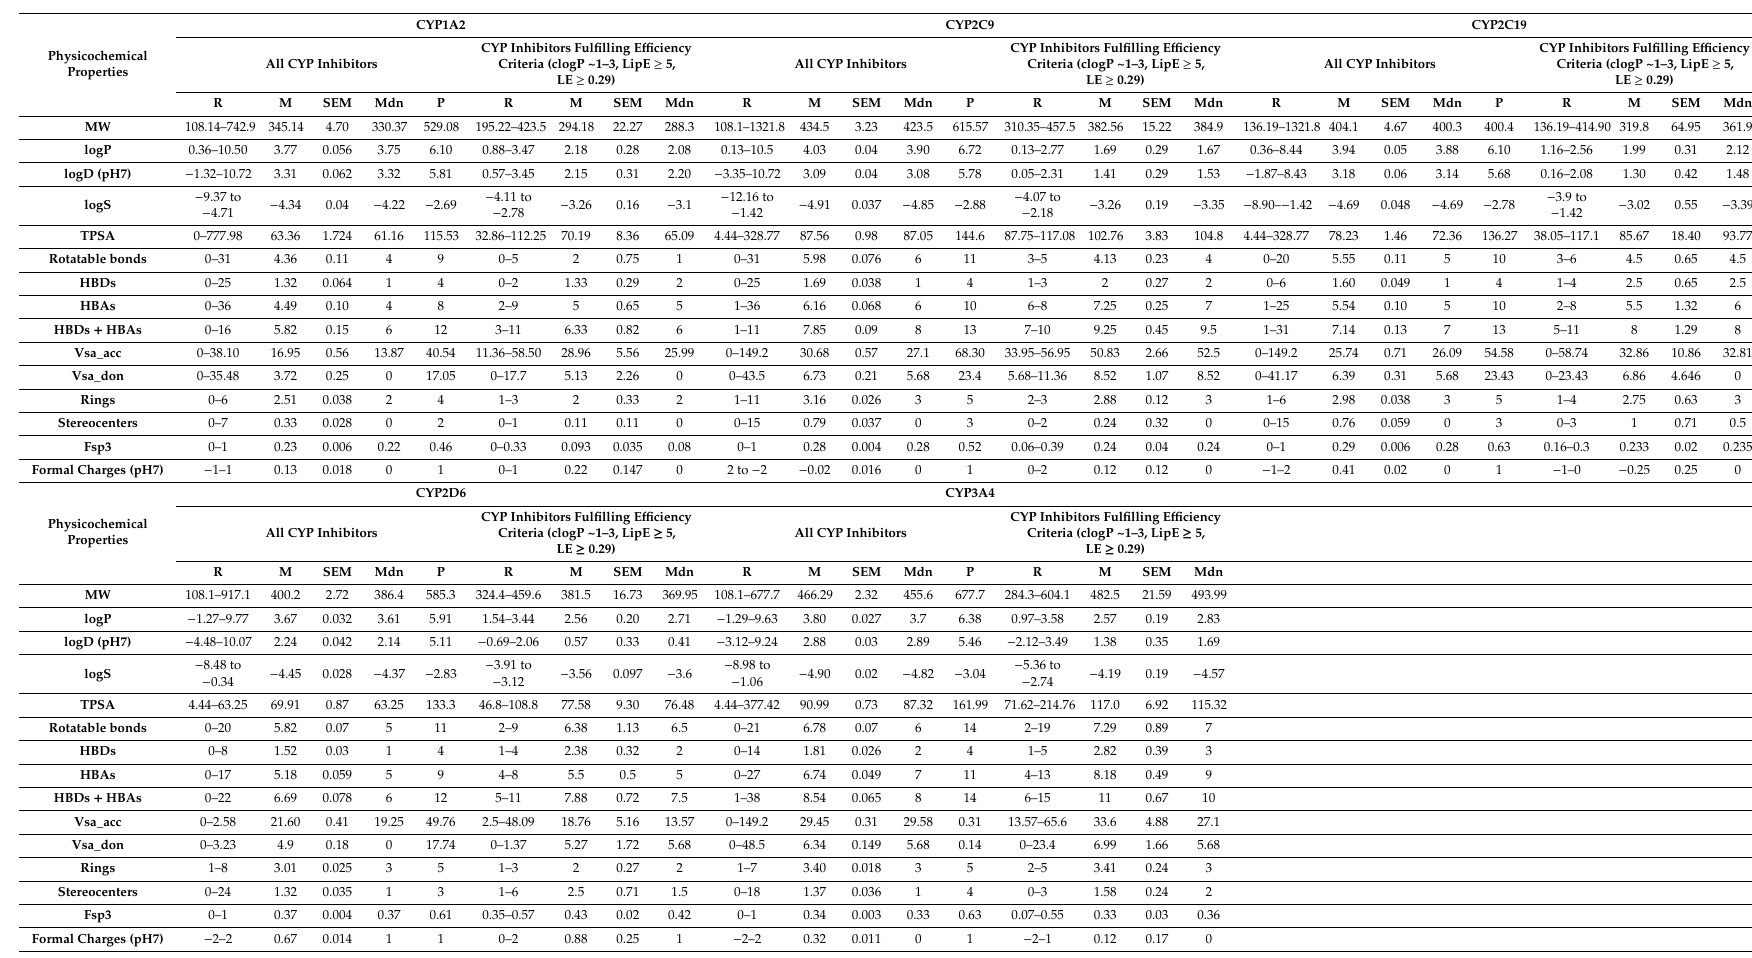
Table 2. The range (R), mean (M), standard error of mean (SEM), median (Mdn) and 95% percentile (P) values for physicochemical parameters of all inhibitors and highly e ffi cient inhibitors of CYP1A2, CYP2C9, CYP2C19, CYP2D6 and CYP3A4. TPSA: Topological polar surface area; HBAs: Hydrogen bond acceptors; HBDs: Hydrogen bond donors; Fsp3: Fraction of sp3 carbons; Vsa_acc: Sum of van der Waals (vdW) surface areas (Å 2 ) of Hydrogen bond acceptors; Vsa_don: Sum of van der Waals (vdW) surface areas (Å 2 ) of Hydrogen bond donors; MW: Molecular